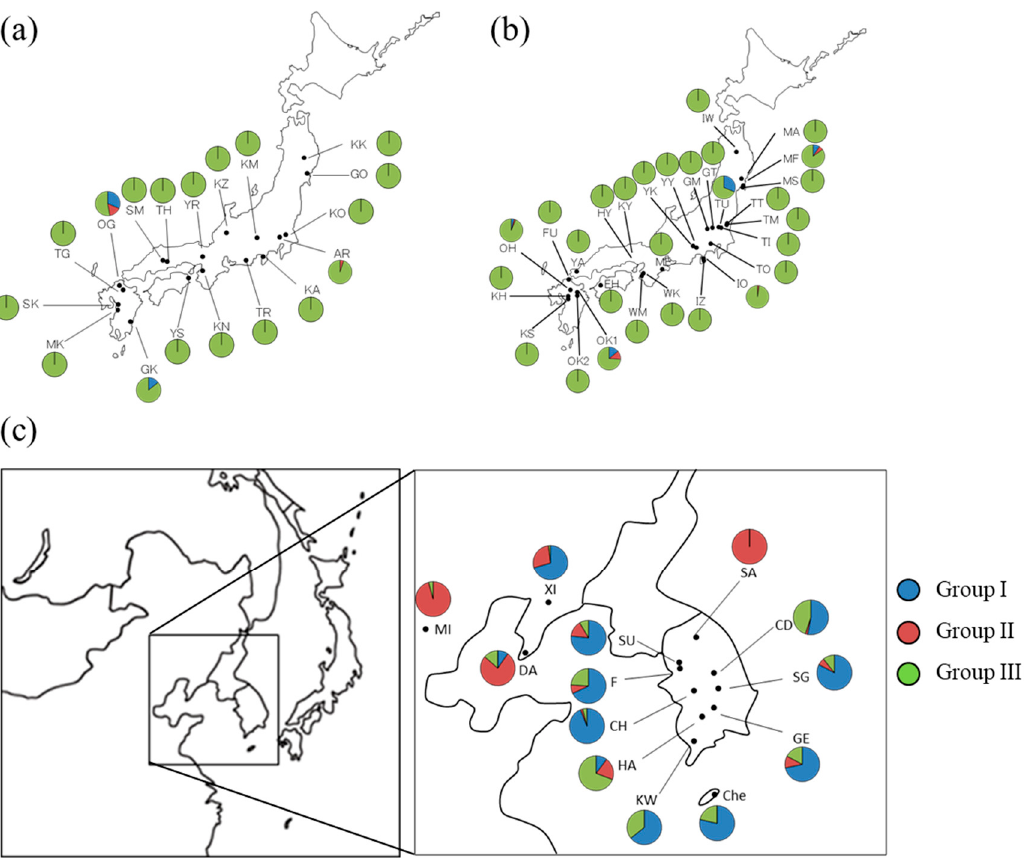
Figure 3. Three chloroplast haplotype group distribution of Q. acutissima for ( a ) 18 natural populations in Japan; ( b ) 28 artificial populations in Japan and ( c ) 13 continental populations.